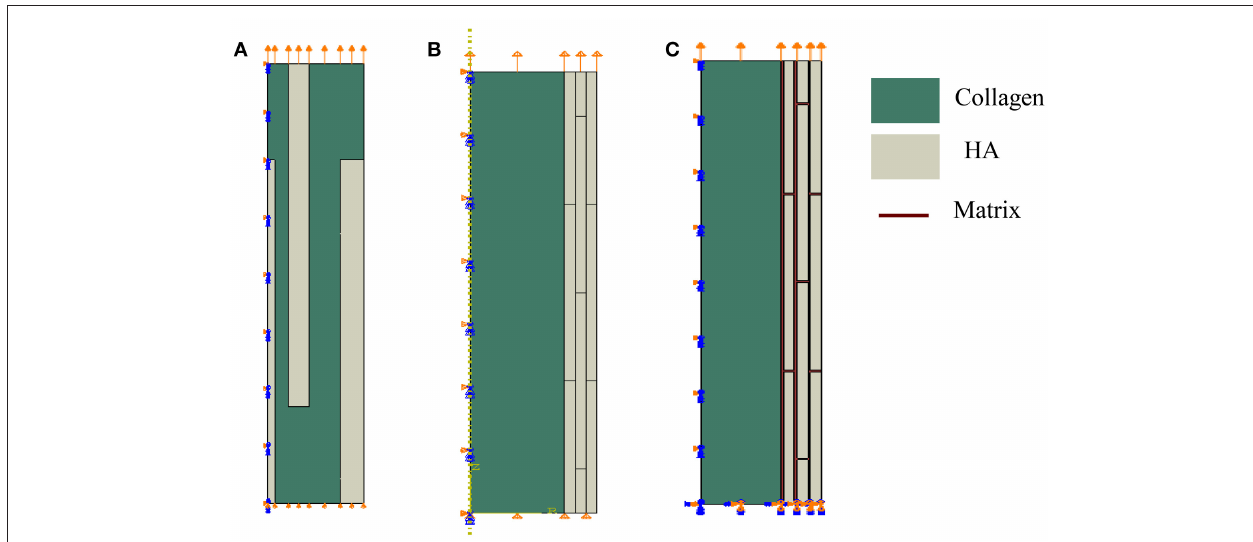
FIGURE 9 | Geometrical models of bone at the nanoscale. Model I: (A) isolated staggered minerals, Model II: (B) mineral lamellae with no matrix, and (C) mineral lamellae with matrix (interphase).